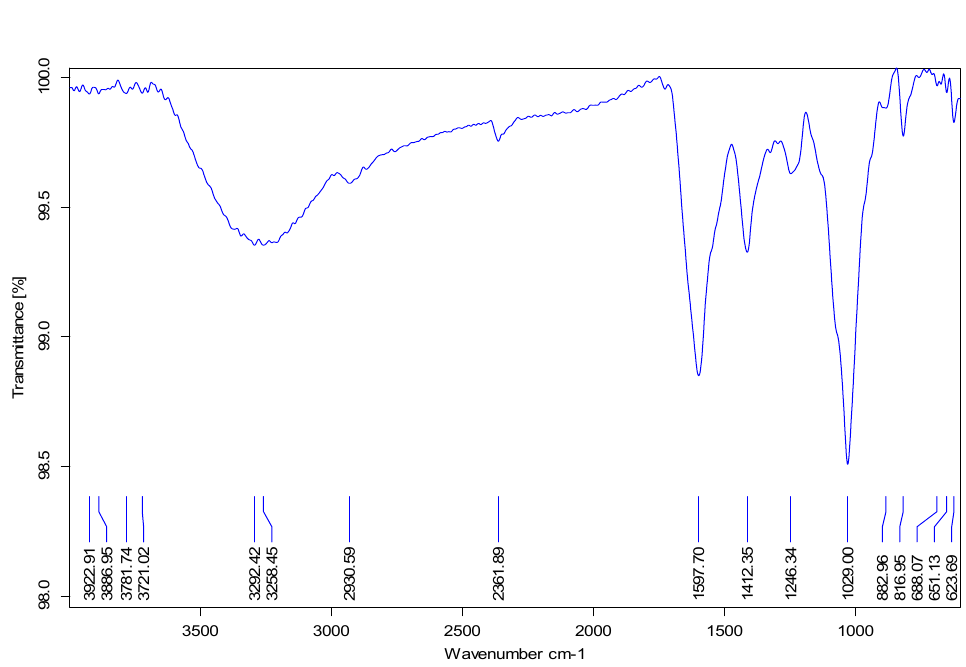
Figure 4. FT-IR spectra of fucoidan fraction isolated from the brown seaweed Sargassum ilicifollium . Table 3. The FT-IR analysis of S. ilicifolium .